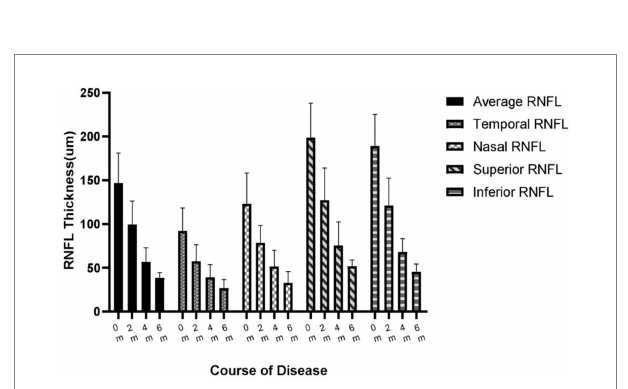
FIGURE 3 Changes in quadrants and average thickness of RNFL at the onset,